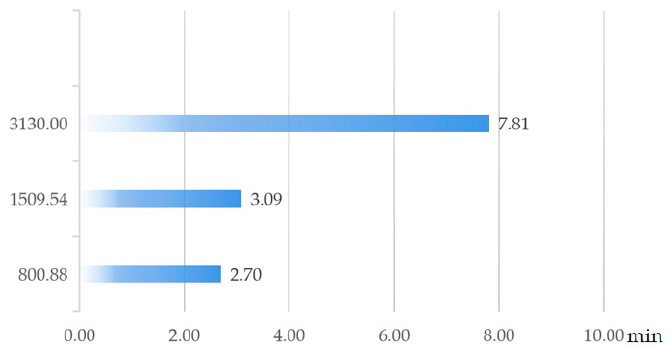
Figure 23. Comparison of forecast time for different areas in Xiji Country.